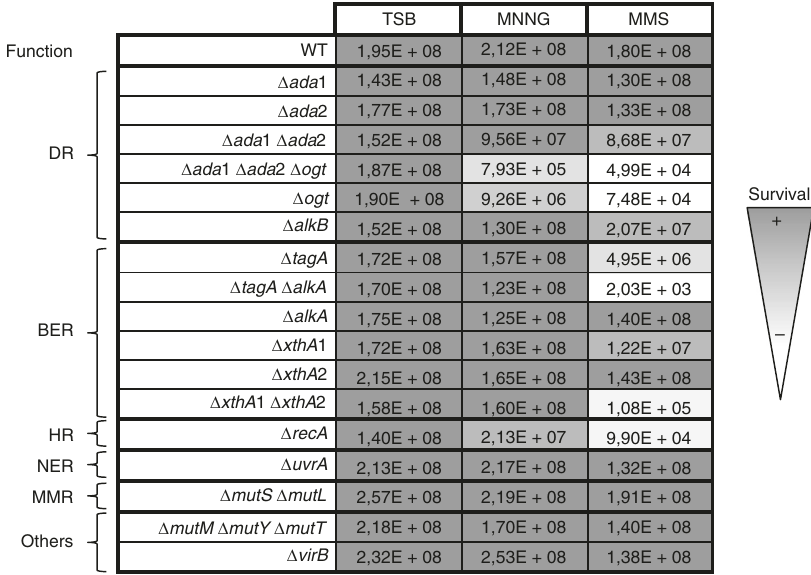
Fig. 4 Survival of DNA repair mutants against alkylating agents in vitro. Deletion strains were plated on rich medium (TSB) supplemented or not with alkylating agents (35 µ M of MNNG or 2.5 mM of MMS). Data shown here are the mean values of colony forming units for biological triplicates. DR stands for direct repair, BER for base excision repair, HR for homologous recombination, NER for nucleotide excision repair, and MMR for mismatch repair. The category “ others ” comprises 8-oxo-dG repair ( mutM mutY mutT ) and the type IV secretion system ( virB ) as negative controls. Source data are provided